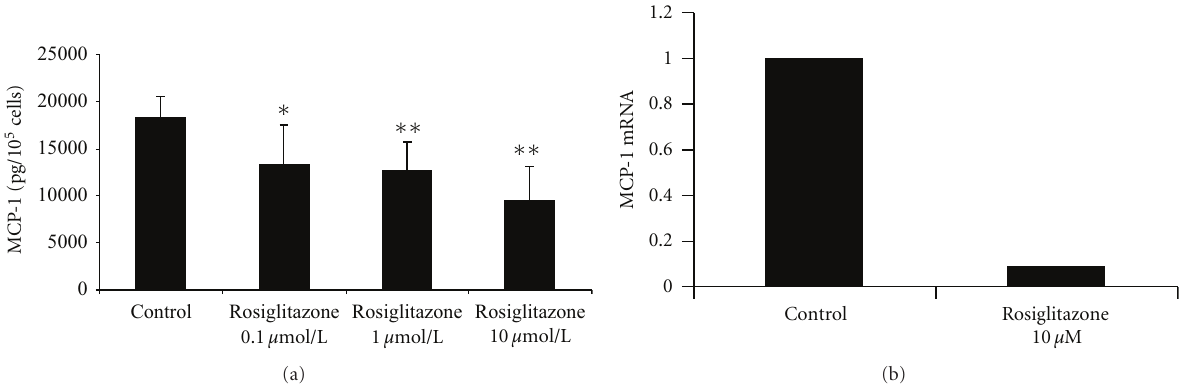
Figure 2: (a) E ff ect of rosiglitazone on mesothelial MCP-1 release. MC were stimulated with rosiglitazone in the given concentrations for 48 hours. MCP-1 antigen was measured in the cell culture supernatants using ELISA technique. ∗ indicates a P value < 0.05; ∗∗ indicates a P value < 0.01 ( n = 6). (b) E ff ect of rosiglitazone on mesothelial MCP-1 mRNA levels. MC were incubated with rosiglitazone 10 μ M for 4 hours. Total RNA was extracted and analysed via RT-PCR. MCP-1 mRNA levels were adjusted to the housekeeper rRNA and are expressed as relative to the control. The figure is a representative of three independent experiments.